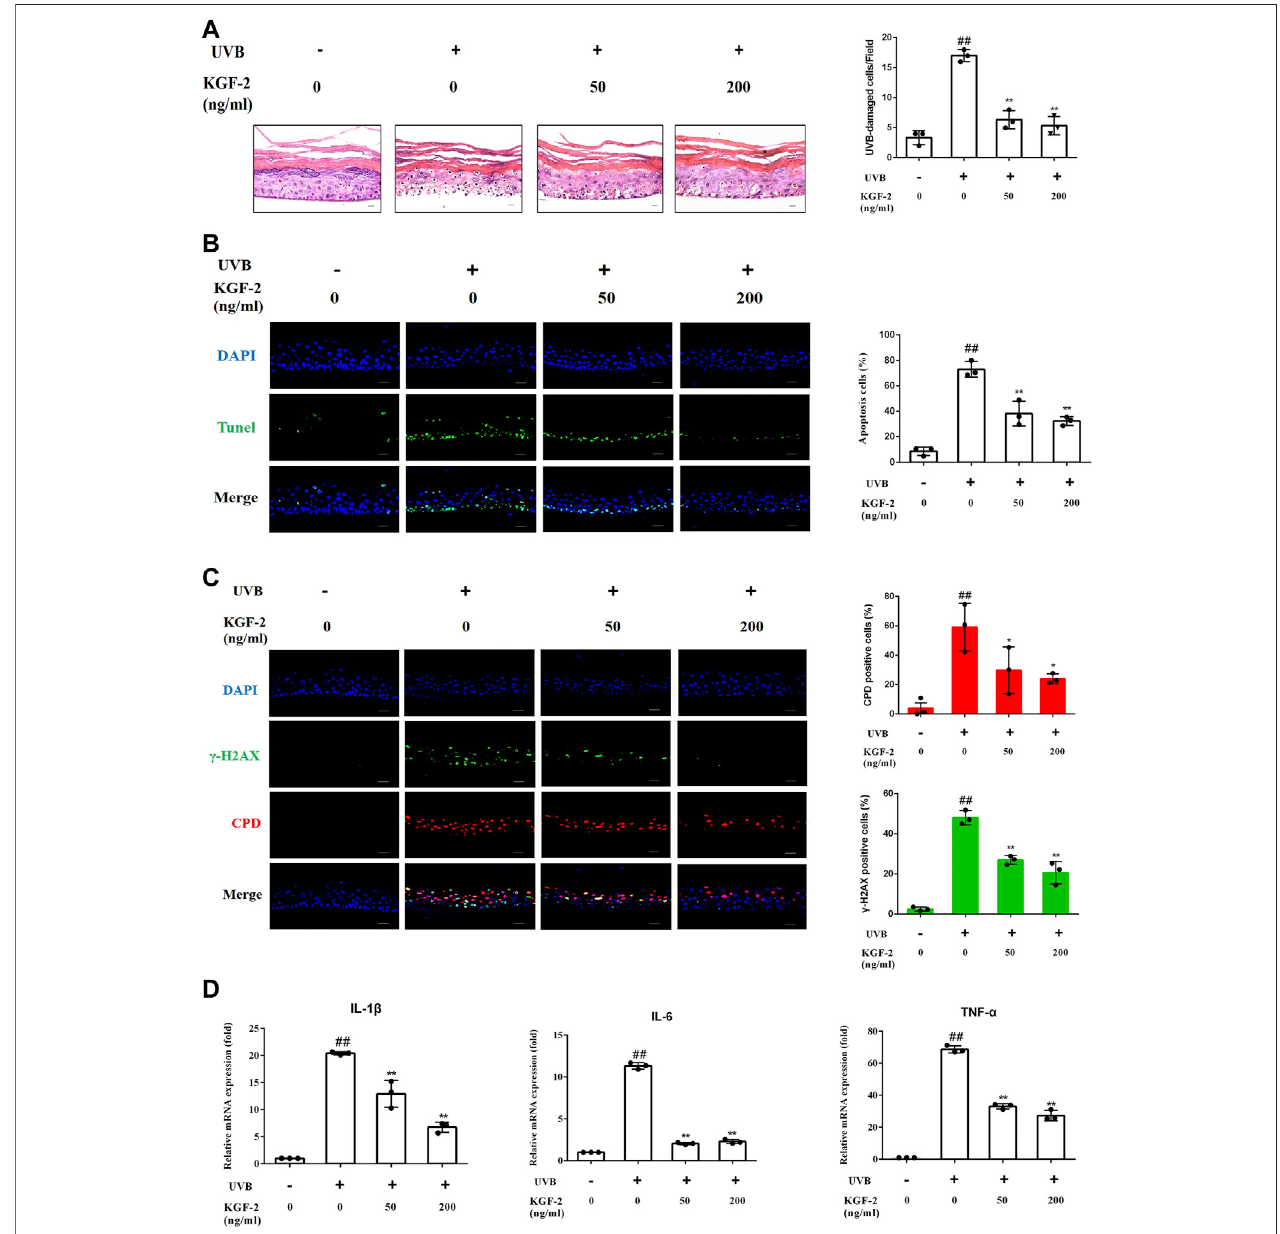
FIGURE1| EffectofKGF-2onUVB-irradiatedHEE.HEEwastreatedwithorwithoutKGF-2(0,50,200 ng/ml)for4 h,andthenirradiatedwith200 mJ/cm 2 doseof UVB. 24 h later, the HEE was collected and subjected to a series of analyses. (A) Specimens of HEE stained with HE, the plot compares the UVB-damaged cell counts takenfromthreeindependentHEEcultures.UVBonly vs. untreatedcontrolgroup, p < 0.0001;KGF-2(50 ng/ml) vs. UVBonlygroup, p < 0.0001;KGF-2(200 ng/ml) vs. UVB only group, p < 0.0001. (B) Representative image of immuno fl uorescence staining of apoptotic keratinocytes; the plot compares the apoptotic cell number withinHEEsfromthreedifferenttreatments.UVBonly vs. untreated controlgroup, p < 0.0001;KGF-2 (50 ng/ml) vs. UVBonlygroup, p (cid:2) 0.0004;KGF-2(200 ng/ml) vs. UVB only group, p (cid:2) 0.0001 (C) Representative immuno fl uorescence images of HEEs stained with anti-CPD and anti- γ -H2AX antibodies, the fi rst plot compares the formation of CPD of HEEs from three different treatments, UVB only vs. untreated control group, p (cid:2) 0.0012; KGF-2 (50 ng/ml) vs. UVB only group, p (cid:2) 0.0393; KGF-2 (200 ng/ml) vs. UVBonlygroup, p (cid:2) 0.0166.Thesecondplotcomparestheformationof γ -H2AXofHEEsfromthree differenttreatments,UVBonly vs. untreated control group, p < 0.0001;KGF-2(50 ng/ml) vs. UVBonlygroup, p (cid:2) 0.0002;KGF-2(200 ng/ml) vs. UVBonlygroup, p < 0.0001. (D) qRT-PCRanalysisofIL-1 β ,IL-6,andTNF- α mRNA levels in HEEs subjected to different treatments. For IL-1 β , UVB only vs. untreated control group, p < 0.0001; KGF-2 (50 ng/ml) vs. UVB only group, p (cid:2) 0.0004; KGF-2(200 ng/ml) vs. UVBonlygroup, p < 0.0001.ForIL-6,UVBonly vs. untreatedcontrolgroup, p < 0.0001;KGF-2(50 ng/ml) vs. UVBonlygroup, p < 0.0001;KGF-2 (200 ng/ml) vs. UVB only group, p < 0.0001. For TNF- α , UVB only vs. untreated control group, p < 0.0001; KGF-2 (50 ng/ml) vs. UVB only group, p < 0.0001; KGF-2 (200 ng/ml) vs. UVBonly group, p < 0.0001. All graphical data arethe means ± SD from three independent experiments, “ # ” and “ ## ” indicate signi fi cantly differentfrom theuntreatedcontrolgroupatthe p < 0.05and p < 0.01levels,respectively, “ * ” and “ ** ” indicatesigni fi cantlydifferentfromtheUVBonlycontrolgroupatthe p < 0.05and p < 0.01 levels,